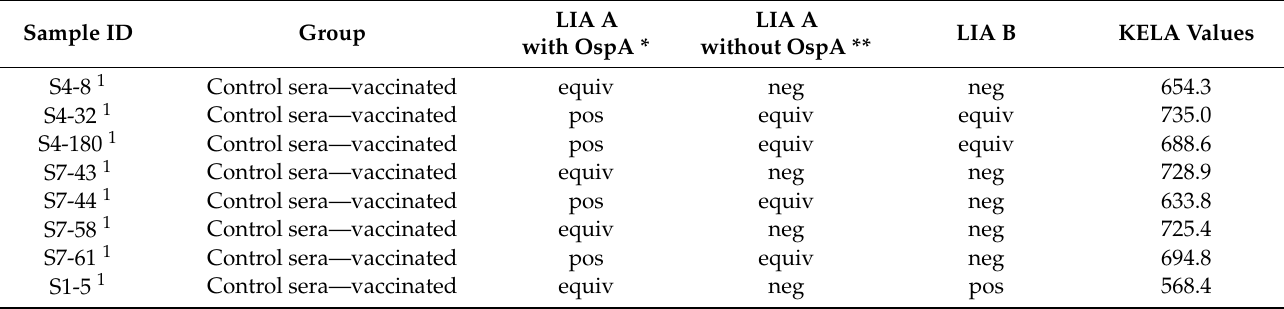
Table 8. Equine serum samples with divergent results in the LIA A due to the recognition of the OspA band as specific for Bb